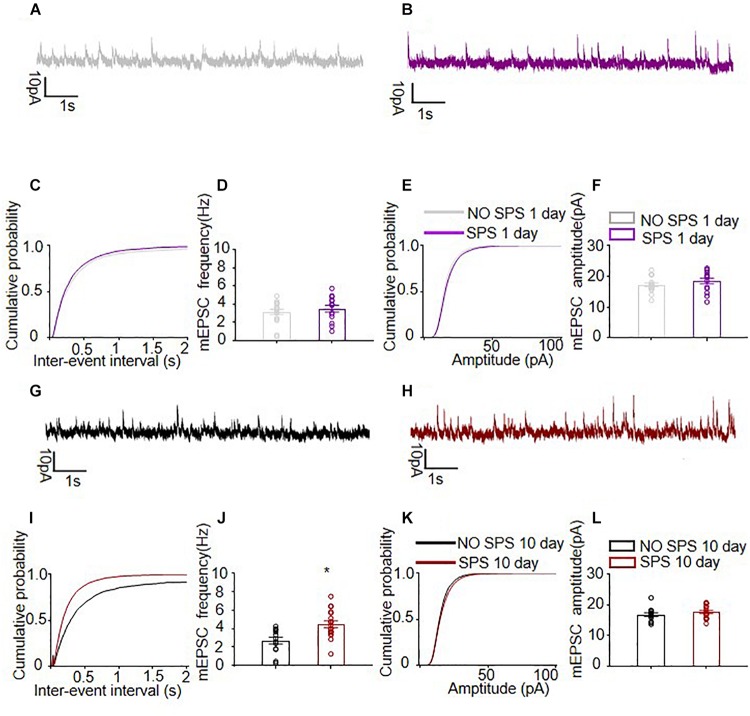
Spontaneous inhibitory quantal synaptic transmission onto BLA pyramidal neurons. (A,B,G,H) Representative examples of mIPSCs of different experimental conditions. (C,I) The cumulative probability distribution of mIPSCs inter-event intervals of BLA pyramidal neurons from SPS group and NO SPS group on the first and tenth day after SPS respectively. (D,J) The mIPSCs frequency of BLA pyramidal neurons from rats on SPS group and NO SPS group. (E,K) The cumulative probability distribution of mIPSCs amplitudes of BLA pyramidal neurons from SPS group and NO SPS group on the first and tenth day after SPS respectively. (F,L) The mIPSCs amplitudes of BLA pyramidal neurons from rats on SPS group and NO SPS group on the first and tenth day after SPS respectively. ∗Different from NO SPS group at each post-SPS day, ∗p < 0.05, one-way ANOVA. Data are shown as means ± SEM.